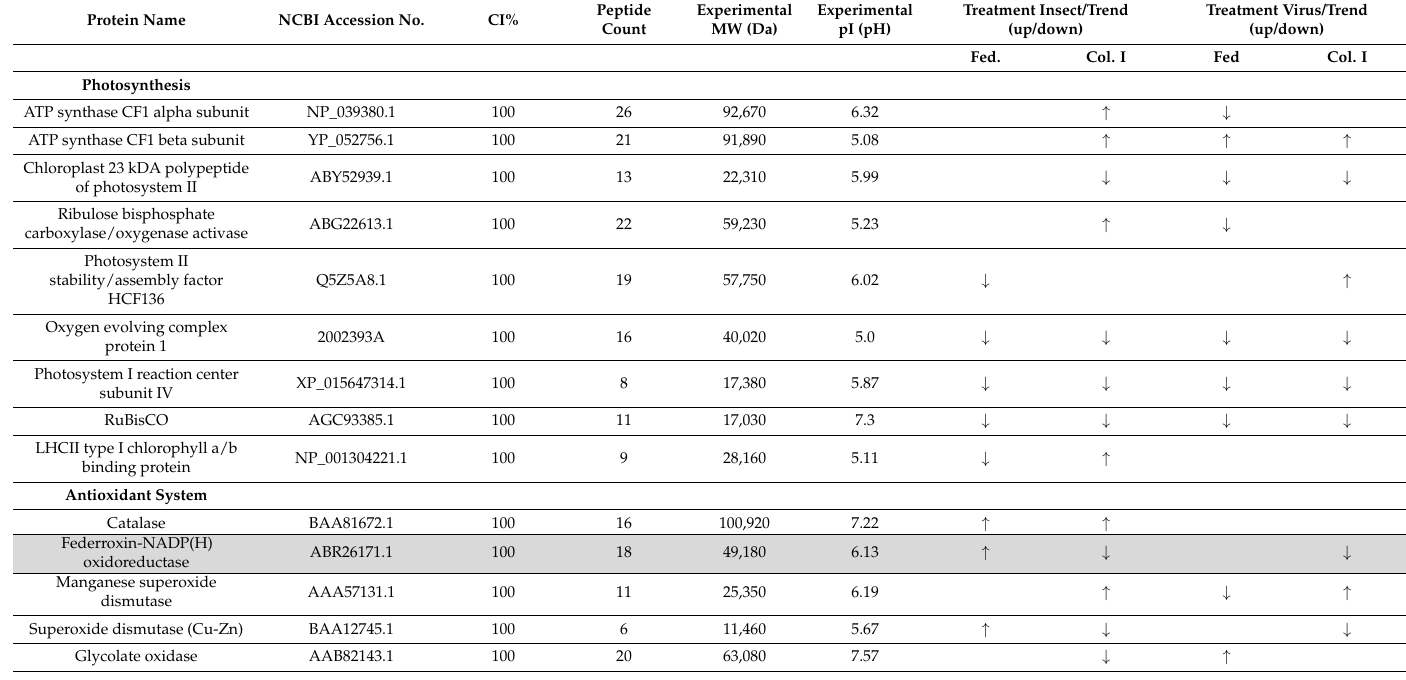
Table 1. MS/MS identification of differentially expressed proteins under non-infected insect and virus-infected insect treatments, in both Fedearroz 2000 (Fed.) and Colombia I (Col. I) varieties (relative abundance). Plants were cultivated in a growth chamber under 12/12 h light/dark cycle at a temperature of 25 ◦ C, and relative humidity of 77%. The plants were irrigated daily with water for approximately 30 days to keep the soil moist. The unstressed and stressed plants were kept in the same growth chamber. CI% = protein score; proteins with 55 or more were considered successfully identified. Treatment Insect = non-infected insect, Treatment Virus = virus-infected insect. Trend: increase ↑ /decrease ↓ respect to control group. Proteins used in the serological assay are highlighted in